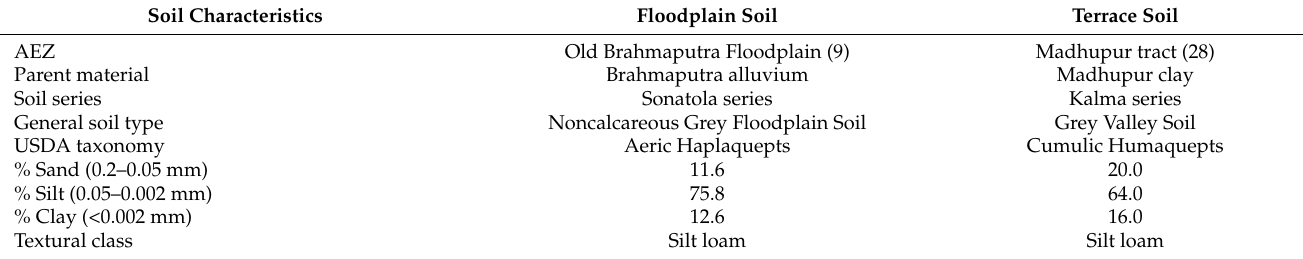
Table 1. Physicochemical properties of the two soils